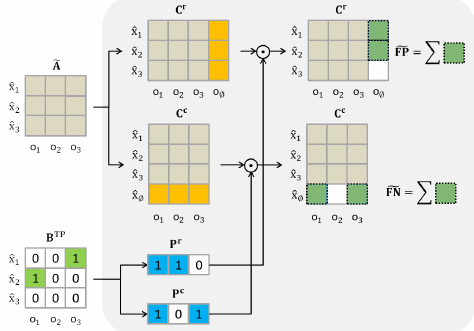
Figure 6. Improved FP and